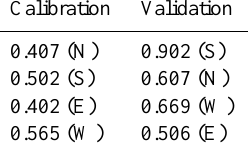
Table 3. Objective function values ( O ) for calibration and vali- dation in different parts of the Wark Catchment; N, S, W and E represents northern, southern, western and eastern part